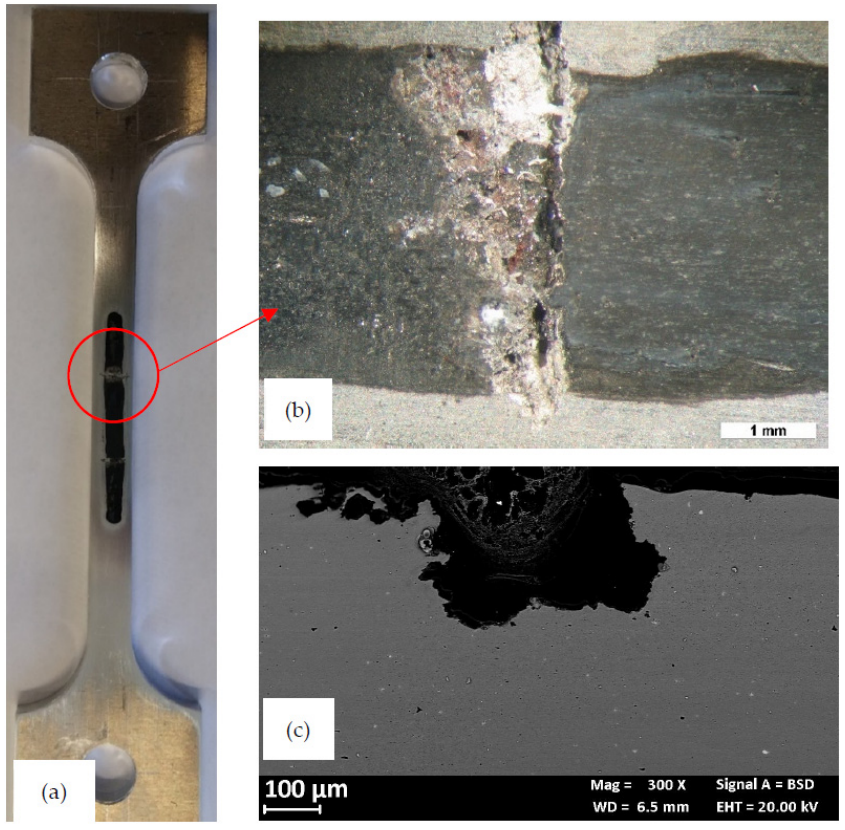
Figure 11. Aspect of the specimen at the end of the constant load test. ( a ) Macro image: the dark zone in the central part exposed to the NaCl 0.6 M solution; ( b ) close ‐ up of the red circle with the selective attack of the TMAZ; ( c ) metallographic section of localized attack.